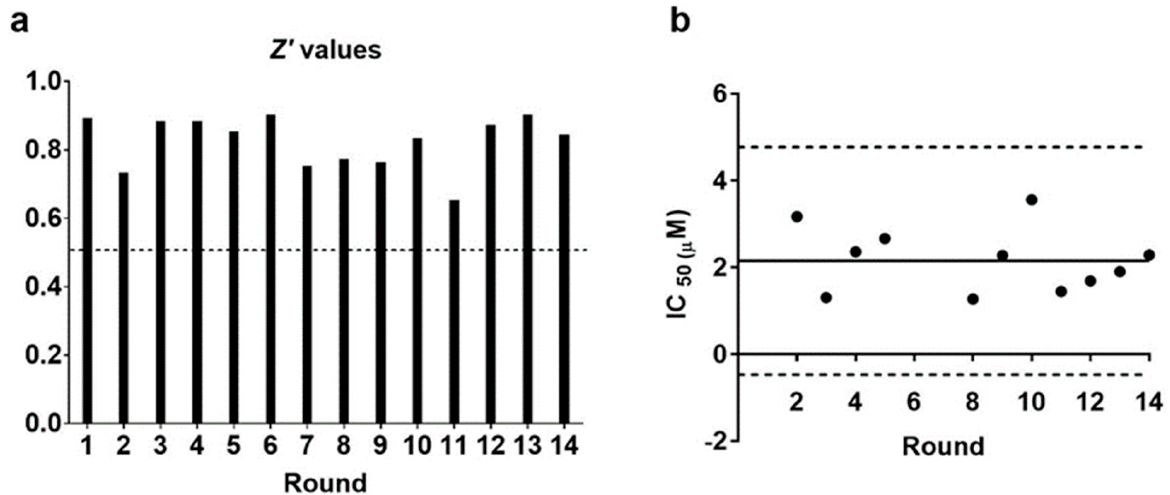
Figure 2. Statistical robustness of the serum parasite inhibition assay. ( a ) Z’ values and ( b ) IC 50 values for BNZ obtained in different assay runs. The dashed line in ( a ) marks the 0.5 threshold, while the dotted lines in panel B represent ±3SD from the mean (continuous line).